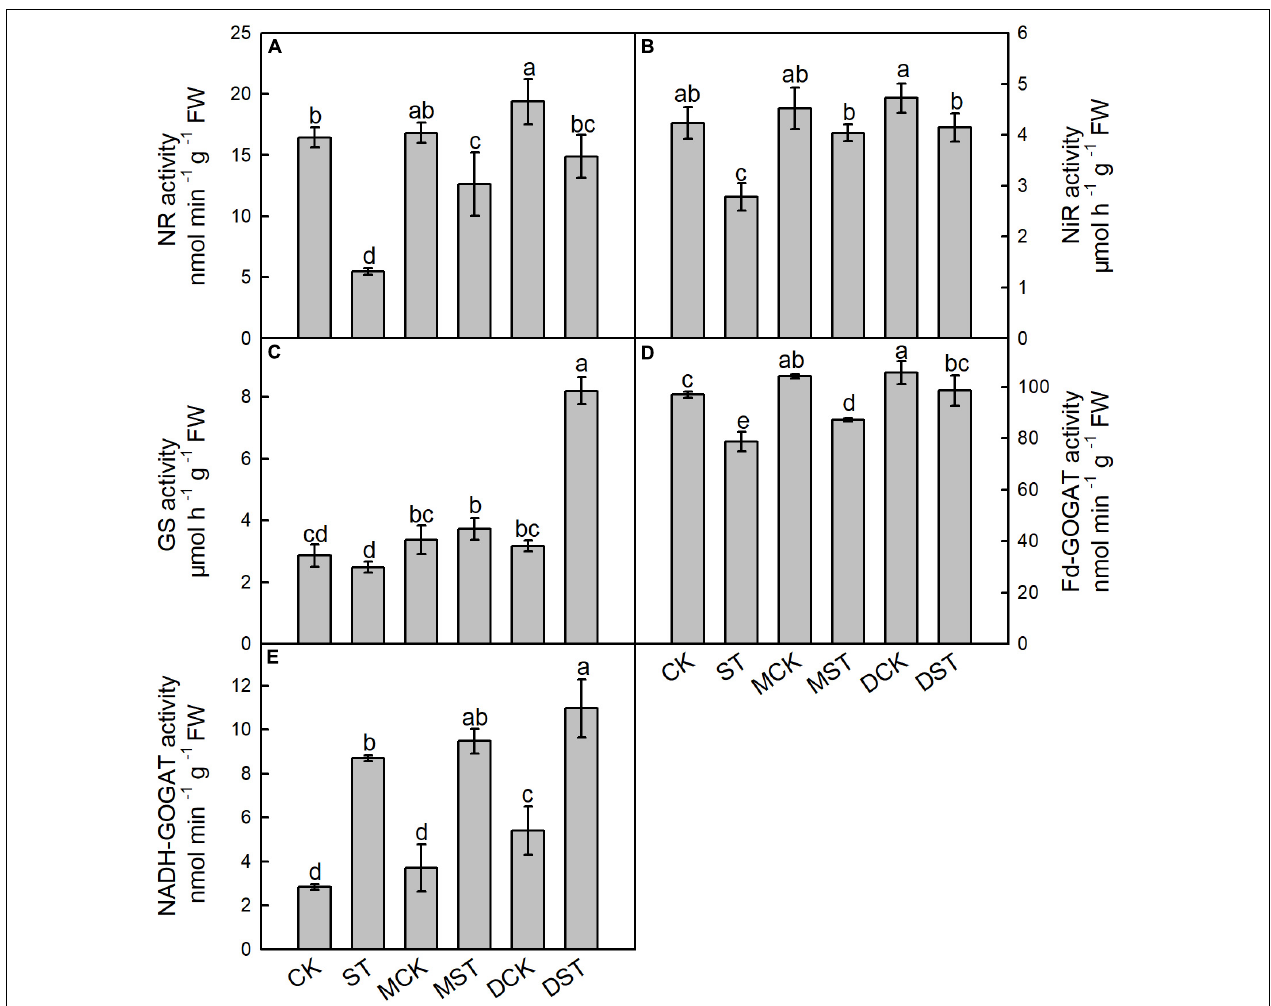
FIGURE 4 | Effects of melatonin and dopamine on activities of nitrate reductase (NR; A ), nitrite reductase (NiR; B ), glutamine synthetase (GS; C ), ferredoxin-dependent glutamate synthase (Fd-GOGAT; D ), and nicotinamide adenine dinucleotide (NADH-GOGAT; E ) in leaves under different treatment conditions. Data are means ± SD ( n = 3). Values not followed by same letter denote significant differences by Tukey’s multiple range tests ( P < 0.05). CK, 2 mM K 15 NO 3 solution; ST, 0.1 mM K 15 NO 3 solution; MCK, 2 mM K 15 NO 3 solution with 0.1 µ mol/L melatonin; MST, 0.1 mM K 15 NO 3 solution with 0.1 µ mol/L melatonin; DCK, 2 mM K 15 NO 3 solution with 100 µ mol/L dopamine; DST, 0.1 mM K 15 NO 3 solution with 100 µ mol/L